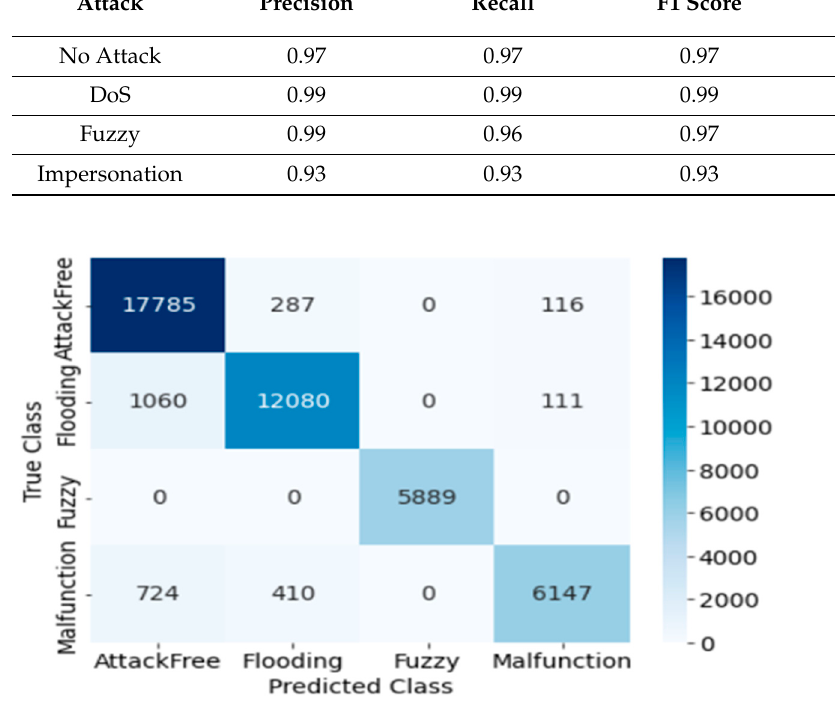
Figure 9. Confusion Matrix of SVM (Dataset 2). Table 6. Detection performance of flooding, fuzzy, malfunction, and attack-free for SVM (Dataset 2).